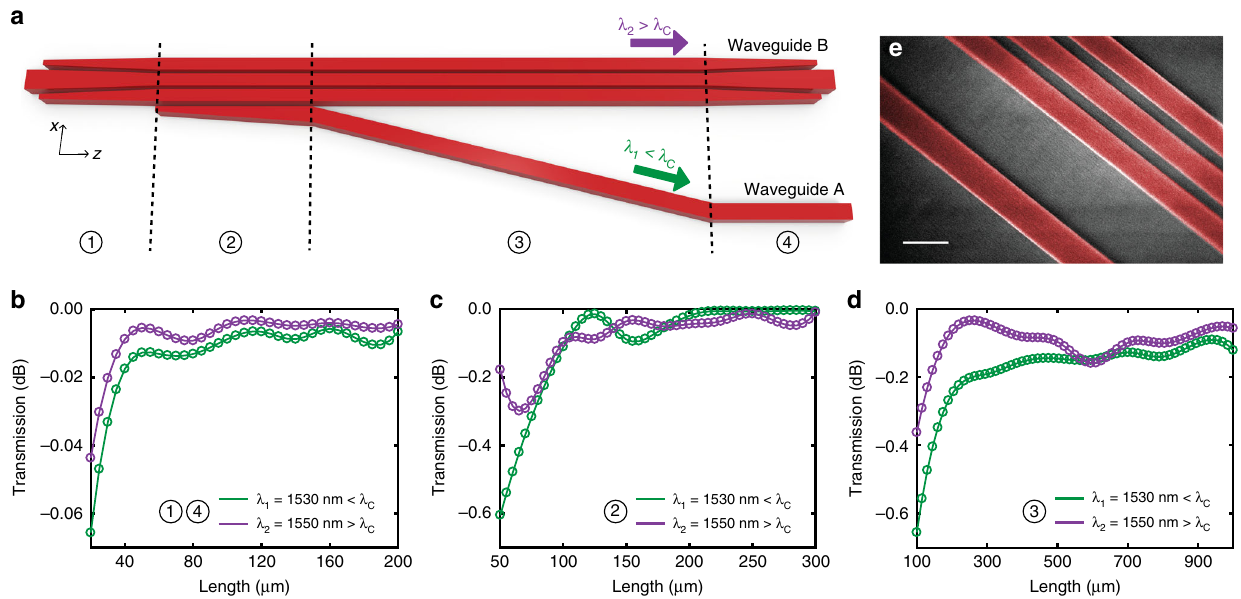
Fig. 3 Optimization of adiabatic transitions and waveguide geometry. a Schematic illustration of short- and long-pass ports of the integrated dichroic fi lter with four transition sections to reach the desired waveguide cross-section. Spectrally selective cross-section is reached just before section ④ , where wavelengths shorter than the cutoff ( λ 1 < λ C ) and longer than the cutoff ( λ 2 > λ C ) are separated to the short- and long-pass ports, respectively. (Si substrate and SiO 2 buried and top oxides are not shown.) b – d Eigenmode expansion simulation results for quasi-even mode for determining the transition lengths for maximum transmission in sections ① and ④ , ② , and ③ . e A colorized scanning electron micrograph showing the fabricated waveguide cross-section. Scale bar,